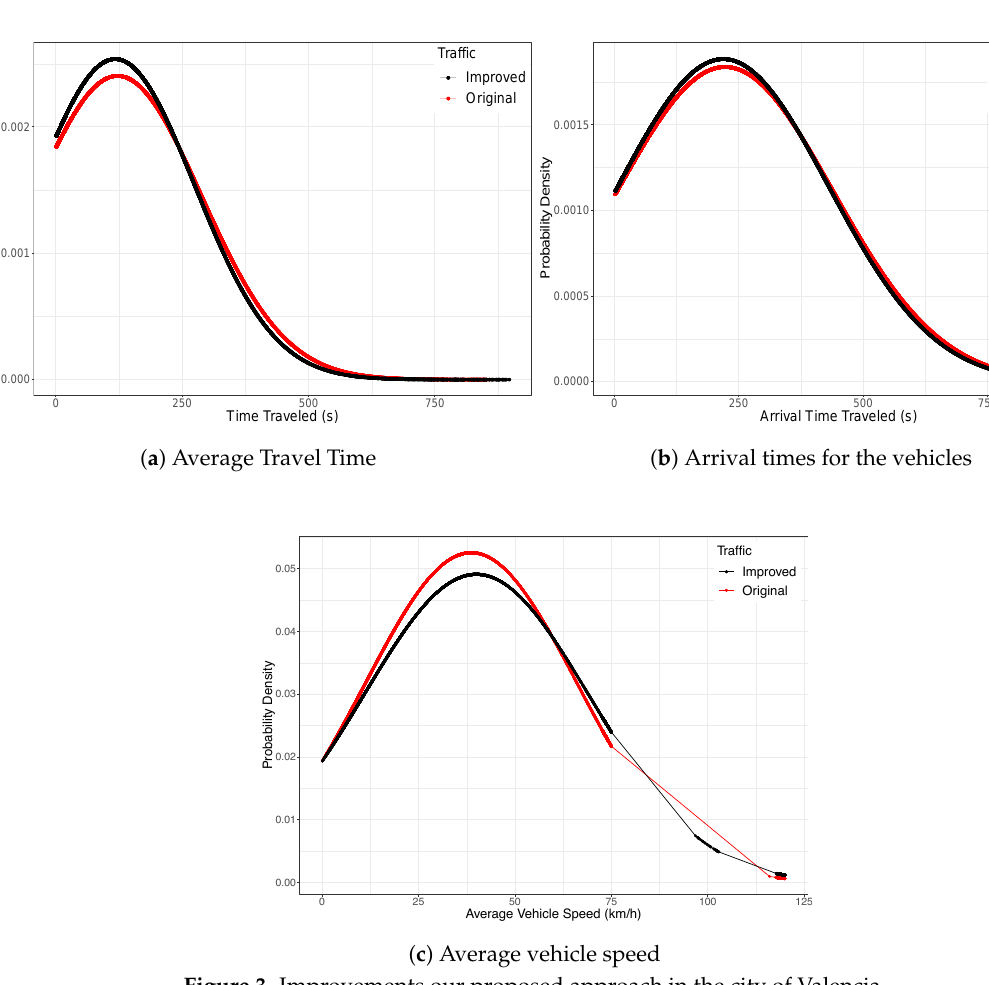
Figure 3. Improvements our proposed approach in the city of Valencia.